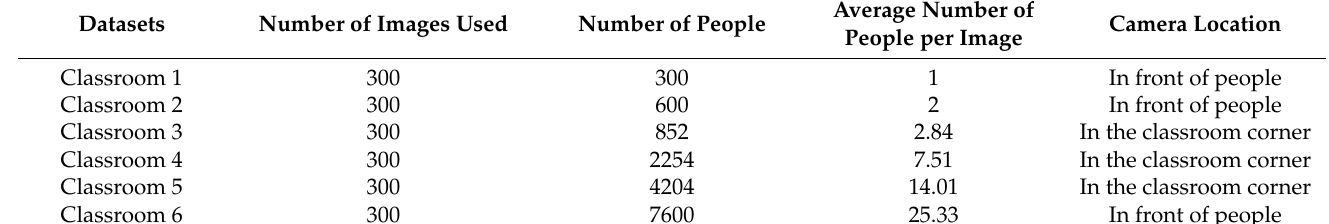
Table 2. Description of the testing dataset.